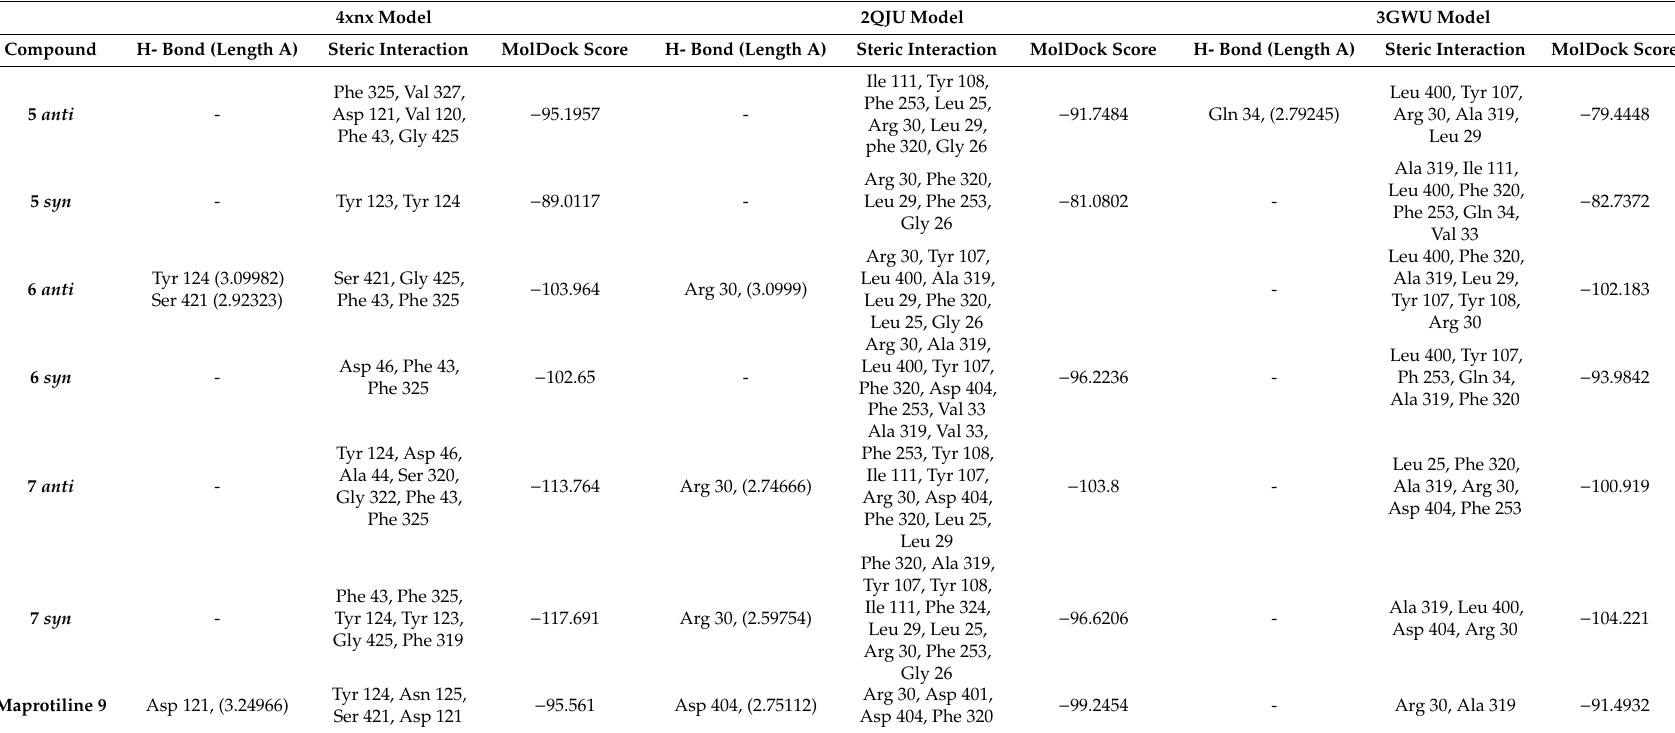
Table 5. The interaction and MolDock scores of the docked compounds with three models: 4xnx, 2QJU, and